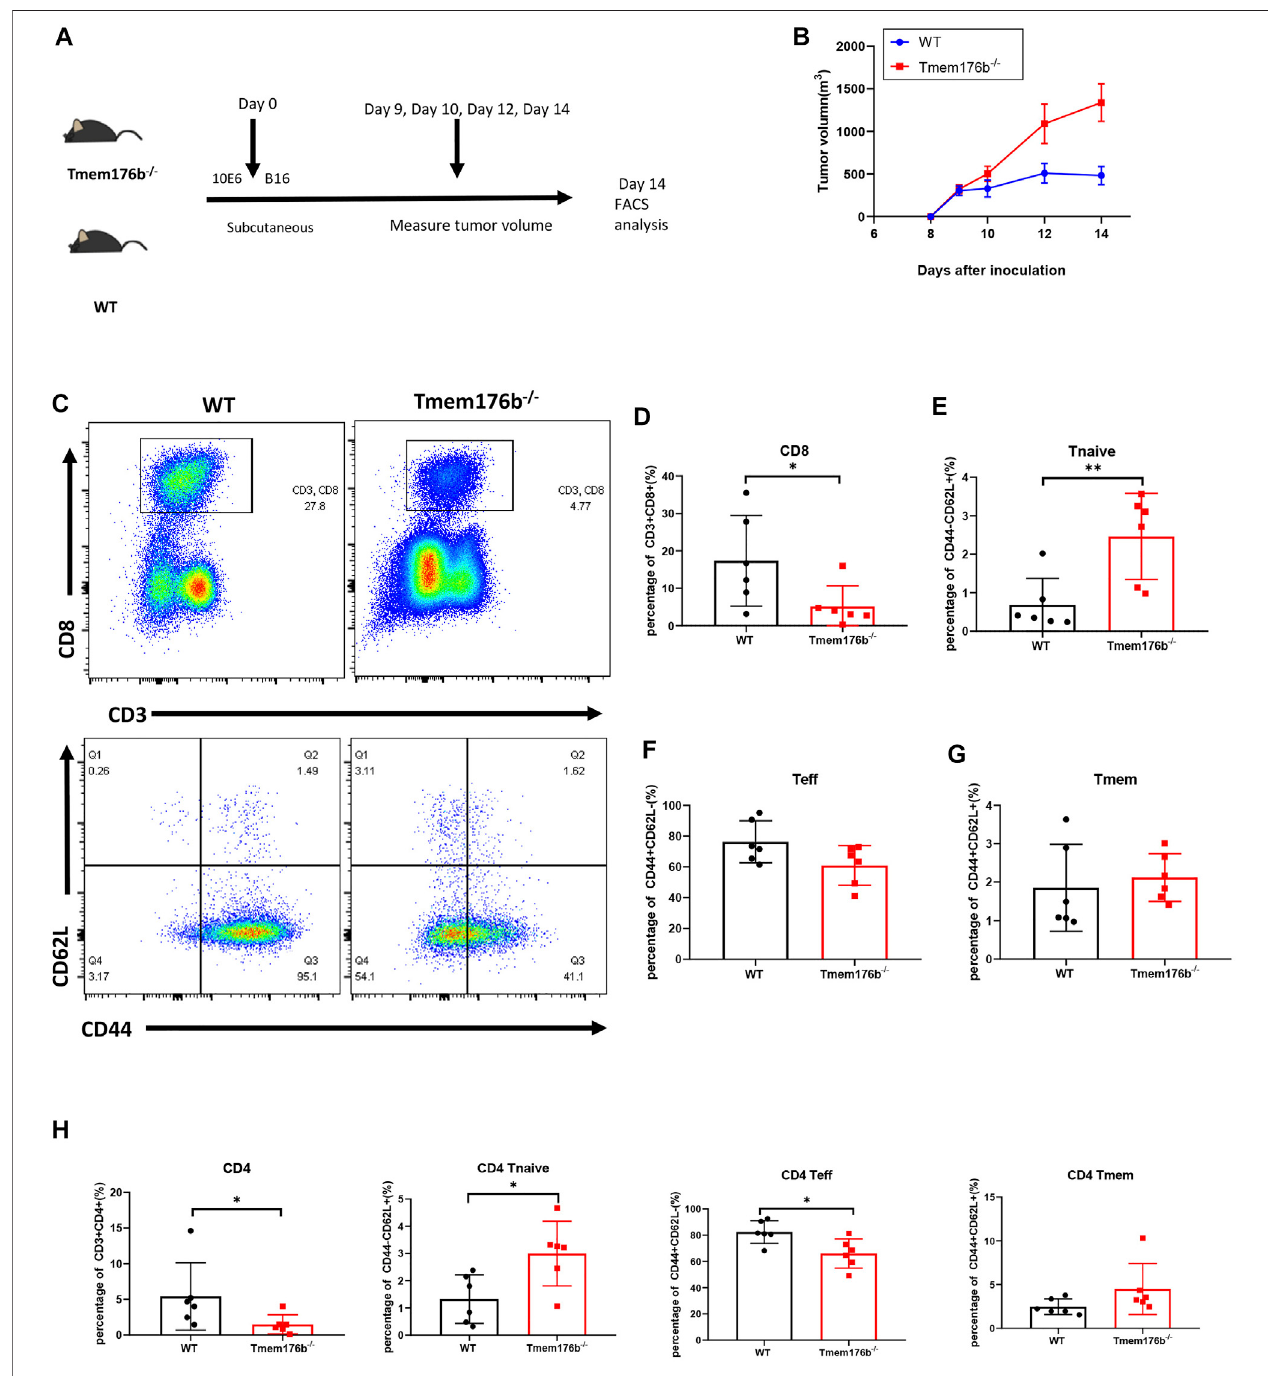
FIGURE5| Theregulatory effect of Tmem176b onTcells aftertumor implantation. (A) Schematicdiagram ofmouse tumor modelexperiment. Sixfemalemiceper group. (B) Tumorgrowth curvesofWT and Tmem176b − / − mice injected subcutaneouslywith1×10 6 B16-OVA melanoma cells (pergroup n =6). (C) Flowcytometryof tumor-in fi ltratinglymphocytesTILCD8 + Tcells(toprows)anditssubgroup(bottomrows)fromWTand Tmem176b − / − miceatday14aftersubcutaneousinjectionwith1 × 10 6 B16-OVA melanoma cells ( n = 6). (D – G) Percentage of tumor-in fi ltrating CD3 + CD8 + T cells and their subpopulations Tnaive, Teff, Tmem from mice as in (C) ( n = 6). (H) Percentage of tumor-in fi ltrating CD3 + CD4 + T cells and their subpopulations Tnaive, Teff, Tmem from mice as in (C) ( n = 6). Each symbol represents a single mouse; data are mean SD from six independent samples. ns, not signi fi cant (two-tailed unpaired Student ’ s t test). * p < 0.05, ** p < 0.01, and *** p < 0.001.